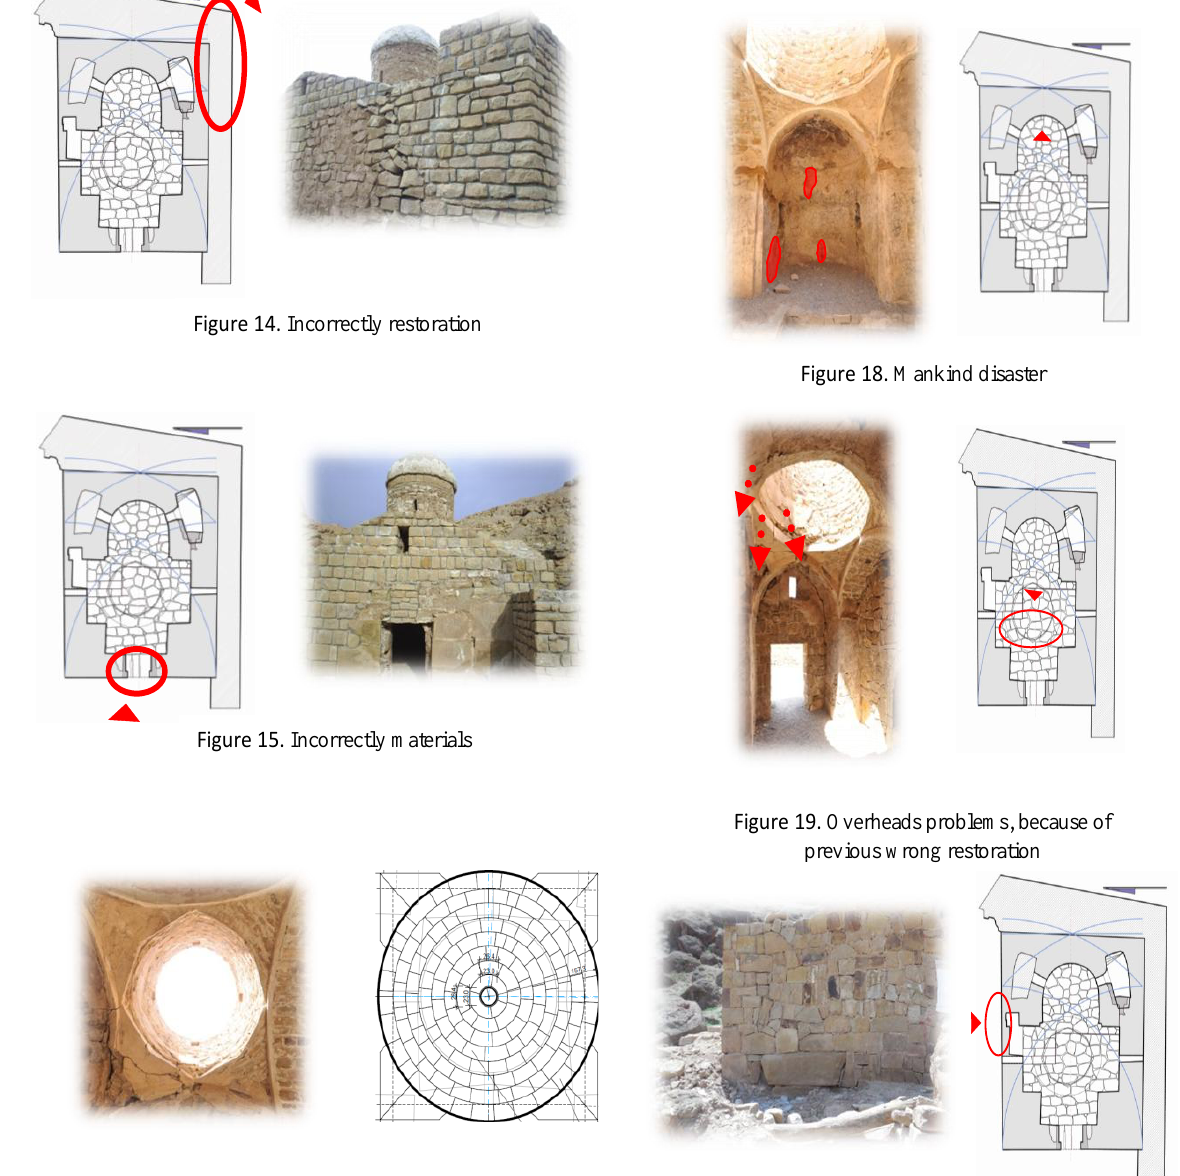
Figure 17. Humidity disaster